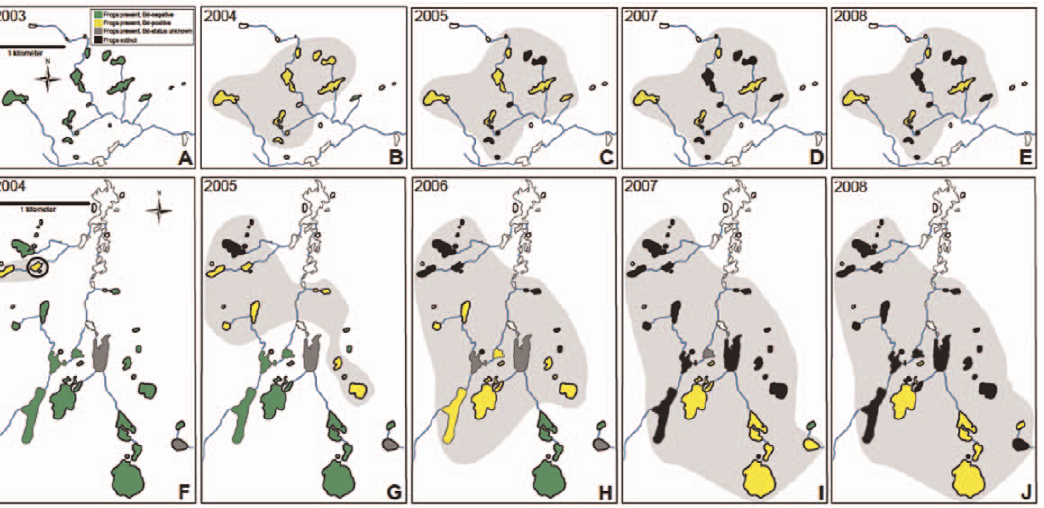
Figure 1. Maps of the two study basins where frog populations were monitored during chytridiomycosis outbreaks. Sequence of maps shows the spread of Batrachochytrium dendrobatidis ( Bd ) through Milestone Basin (A–E) and Sixty Lakes Basin (F–J). Lake color (green for Bd - negative populations, yellow for Bd -infected populations, and black for extinct frog populations) shows Bd infection and frog population status, and the light gray shaded region surrounds the area where frog populations were Bd -positive in each year. Open circle indicates the pond where Bd was first detected and where moribund frogs were collected for blood samples in 2004. Modified from [17]. doi:10.1371/journal.pone.0035374.g001 PLoS ONE |